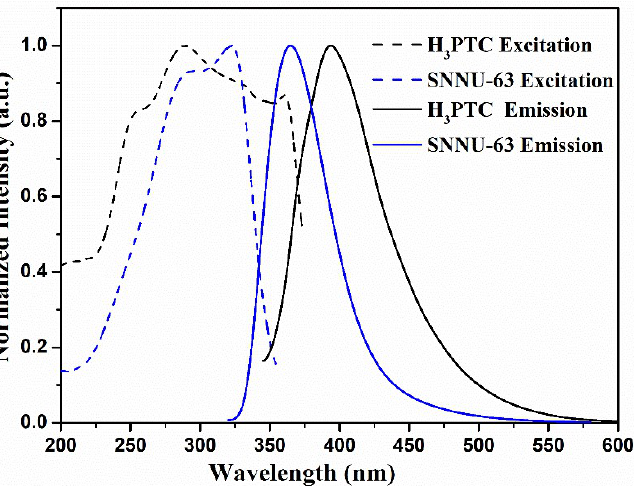
Figure 2. Solid-state excitation and emission spectra of SNNU-63 and the free H 3 PTC ligand.